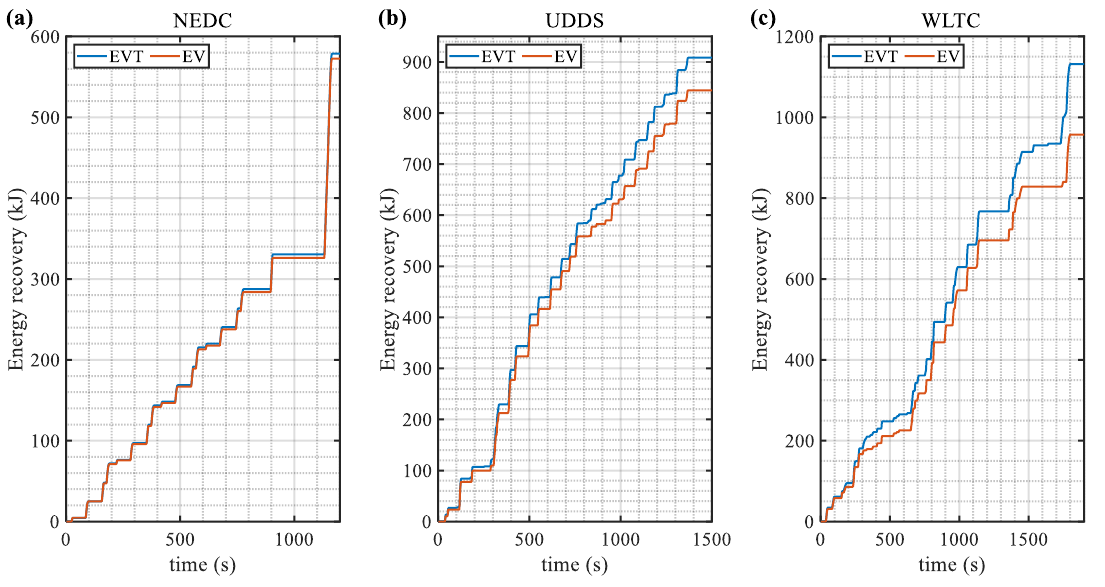
Figure 16. Braking recovery energy curves in three driving cycles: (a) NEDC driving cycle; (b) UDDS driving cycle; (c) WLTC driving cycle. Table 2. The final value of battery SOC and braking energy recovery.